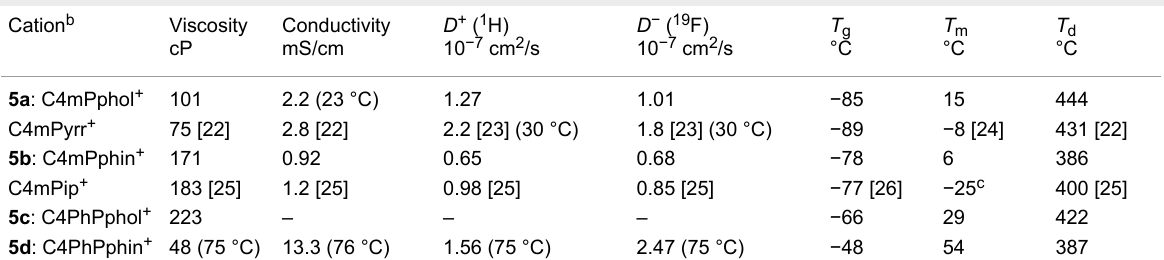
Table 1: Physical characteristics of cyclic phosphonium NTf 2 ILs. a Cation b